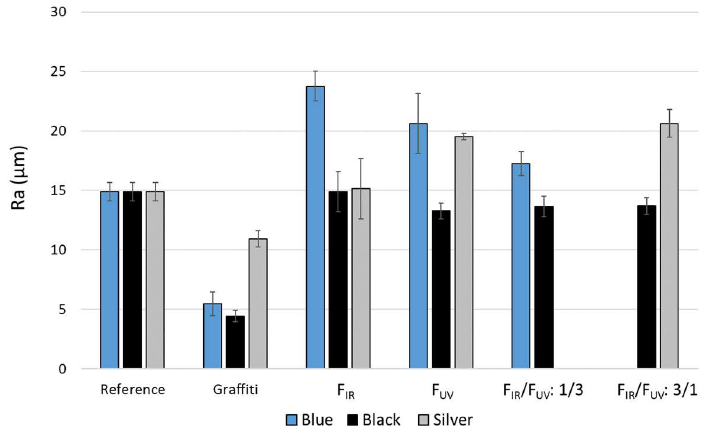
Figure 9. R a (µm) of the areas treated with the selected laser conditions to extract blue, black, and silver graffiti paints using 1064 nm (IR), 355 nm (UV) and their simultaneous use at different F IR / F UV ratios. The roughness values of the reference granite and non-irradiated graffiti surfaces are provided. Standard deviation values are also shown. Detailed information on fluence values and pulses for each irradiation condition can be found in Table 2 (For interpretation of the references to color in this figure legend, the reader is referred to the web version of this article).